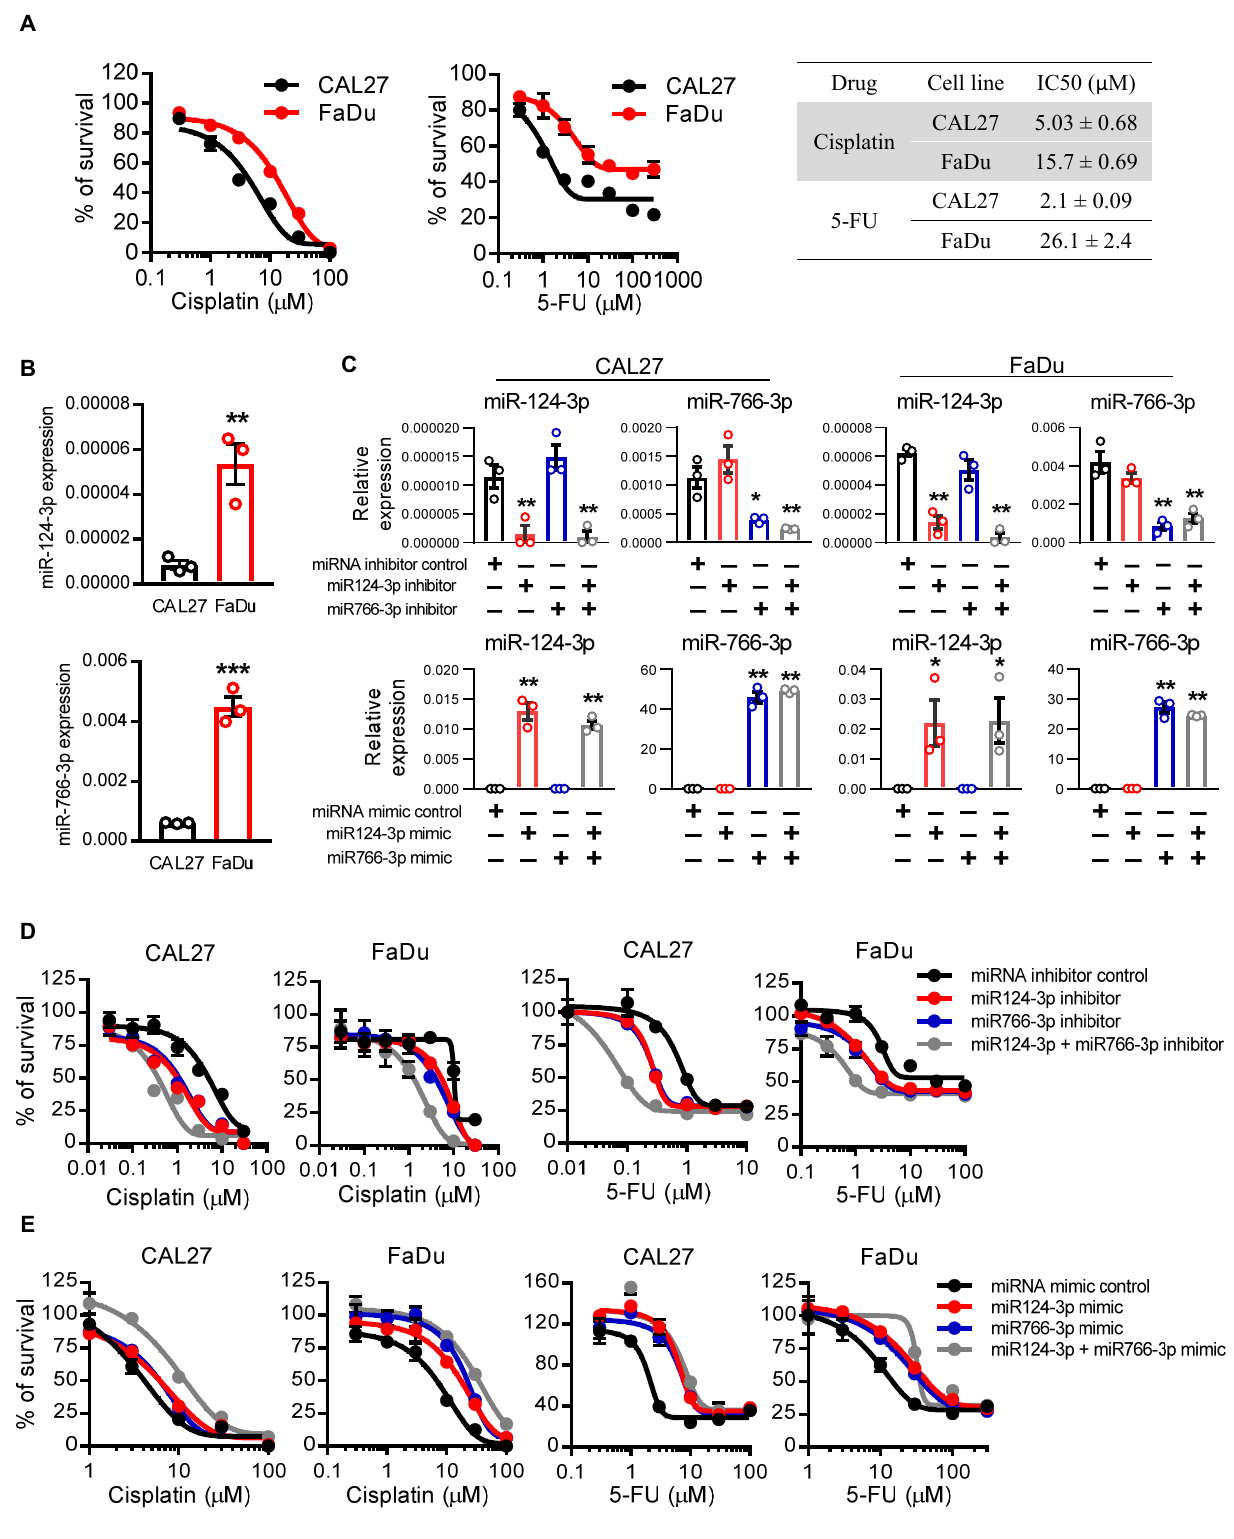
Figure 2. The effect of miR766-3p and miR124-3p expression on HNSCC cell sensitivity to chemother- apeutic drugs. ( A ) Dose–response curves of CAL27 and FaDu cell lines towards cisplatin and 5-FU. IC 50 values were listed in the table. Cell viability was assessed using MTT assay. ( B ) qRT-PCR measurement of miR124-3p and miR766-3p expression in CAL27 or FaDu cell lines. ( C ) qRT-PCR measurement of miR124-3p and miR766-3p expression in CAL27 or FaDu cell lines following trans- fection with miRNA inhibitors (10 nM, left) or miRNA mimics (10 nM, right). ( D , E ) Measurement